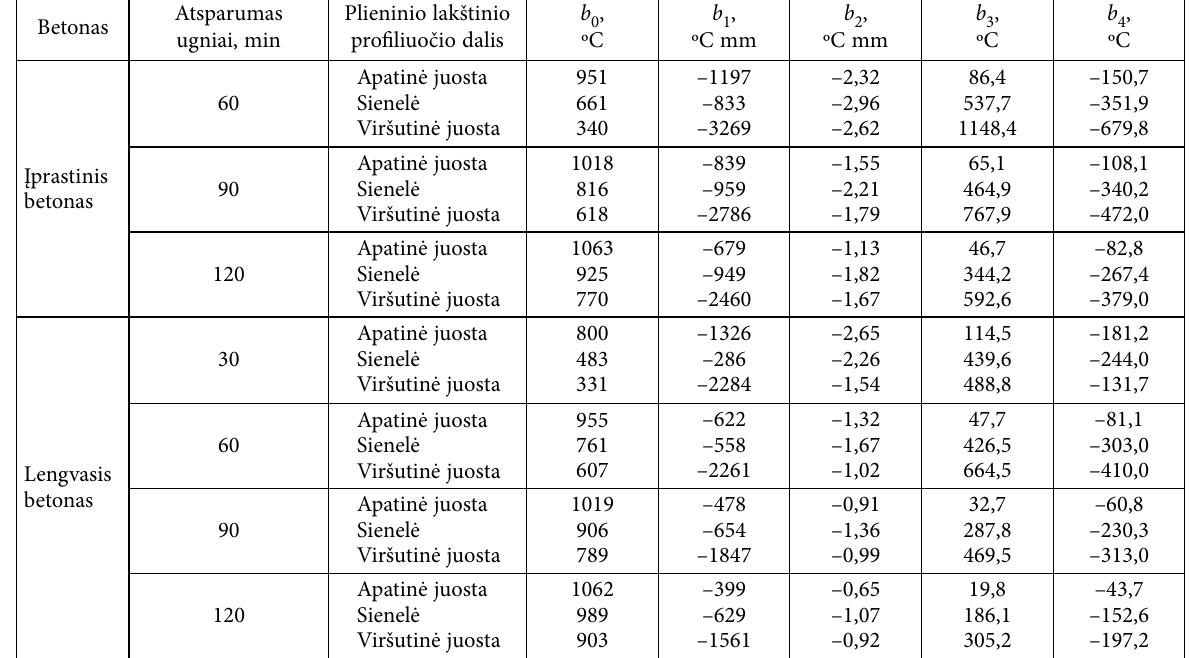
Table 2. Coefficients for temperature evaluation in profiled steel sheet